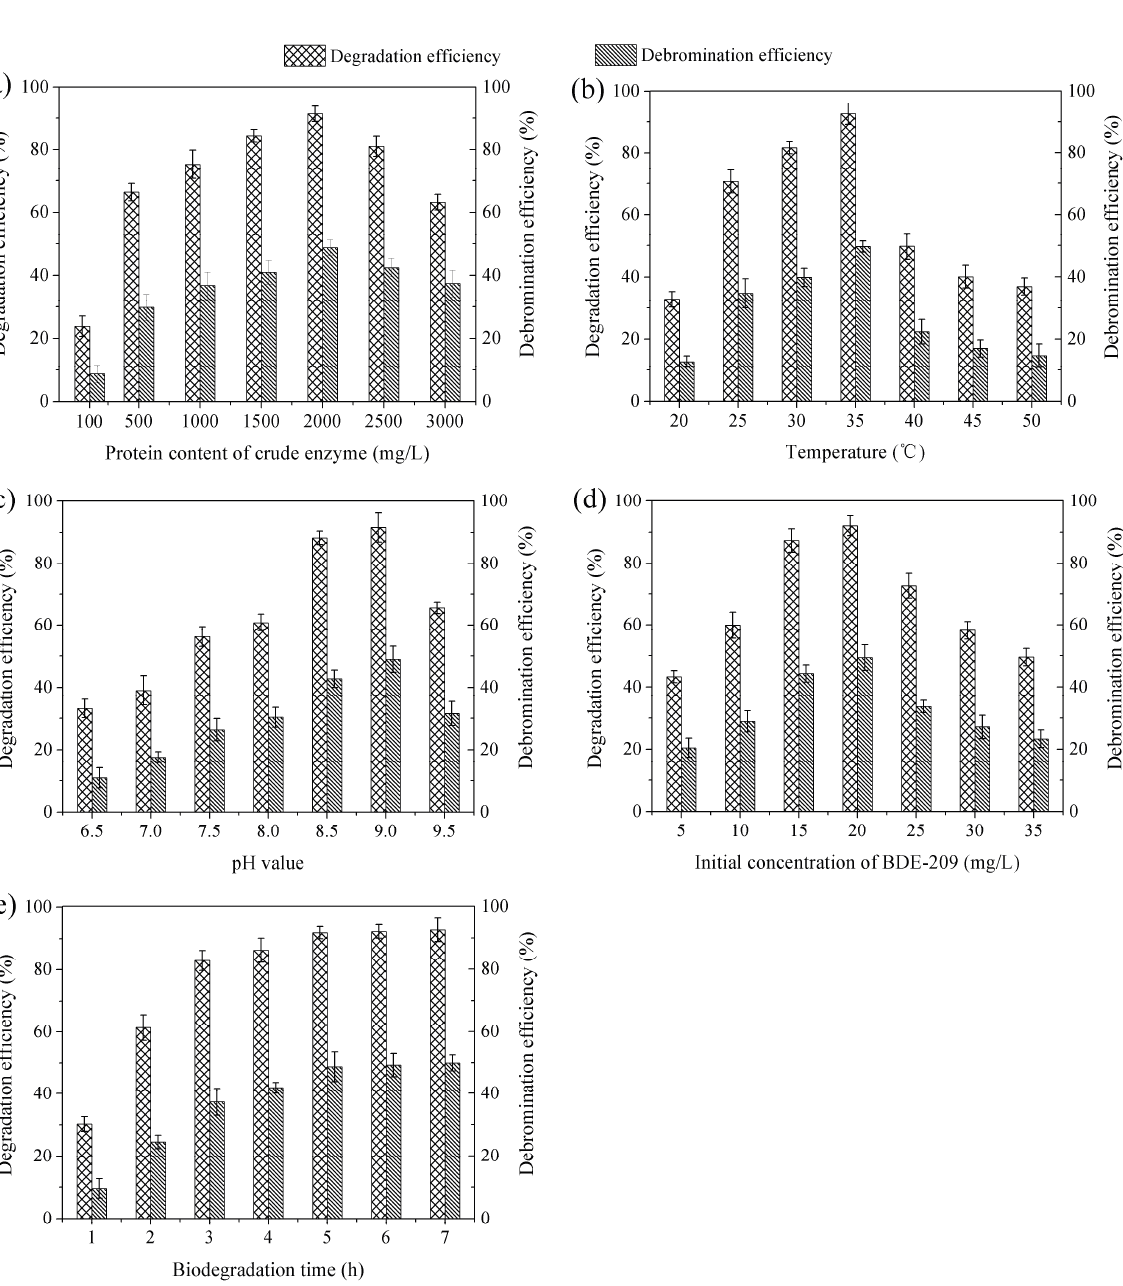
Figure 4. Degradation efficiency and debromination efficiency of BDE-209 by crude enzyme extract under different conditions. ( a ) Protein content of crude enzyme was set at 100-3000 mg/L, other conditions were set at 35 °C, pH 9.0, BDE-209 20 mg/L and 5 h; ( b ) Temperature was set at 20–50 °C, other conditions were set at crude enzyme 2000 mg/L, pH 9.0, BDE-209 20 mg/L and 5 h; ( c ) pH value was set at 6.5–9.5, other conditions were set at crude enzyme 2000 mg/L, 35 °C, BDE-209 20 mg/L and 5 h; ( d ) Initial concentration of BDE-209 was set at 5–35 mg/L, other conditions were set at crude enzyme 2000 mg/L, 35 °C, pH 9.0 and 5 h; ( e ) Biodegradation time was set at 1–7 h, other conditions were set at crude enzyme 2000 mg/L, 35 °C, pH 9.0 and BDE-209 20